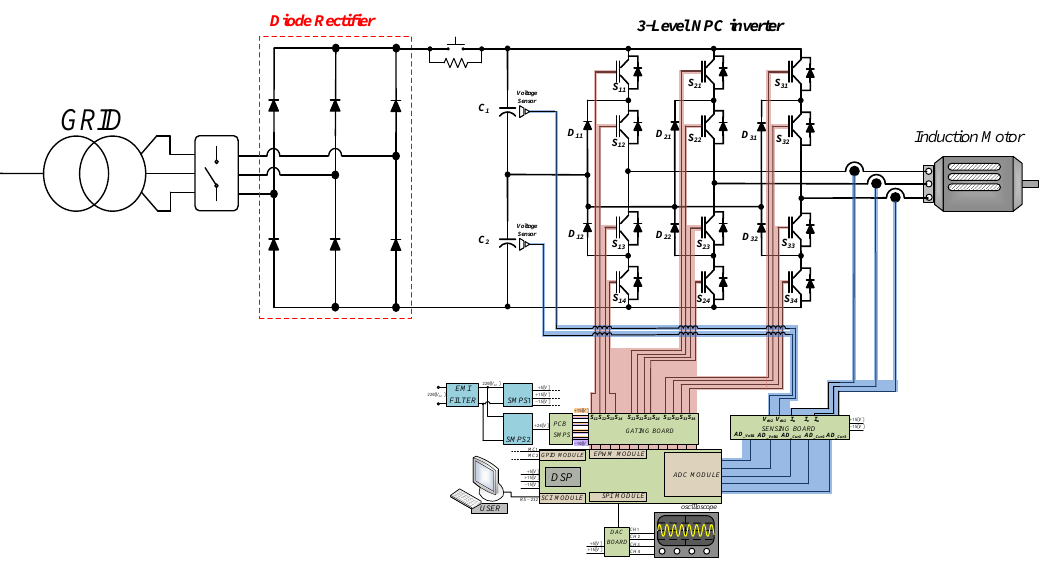
Figure 8. Experiment setup structure.